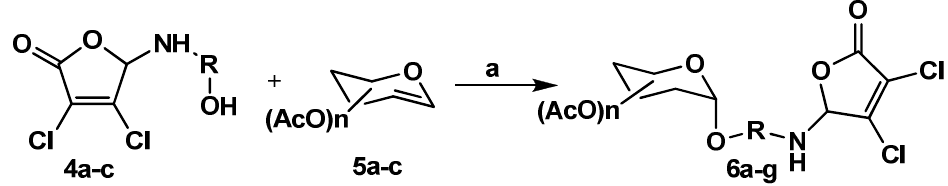
Scheme 3. The coupling of MCA derivatives with peracetylated glucals.